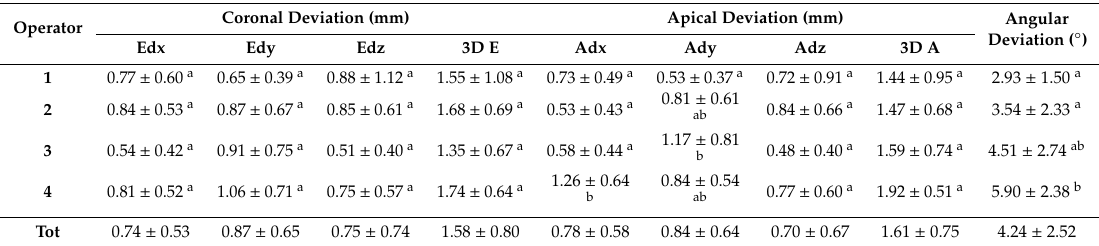
Table 1. Implant placement deviations (mean ± standard deviation).